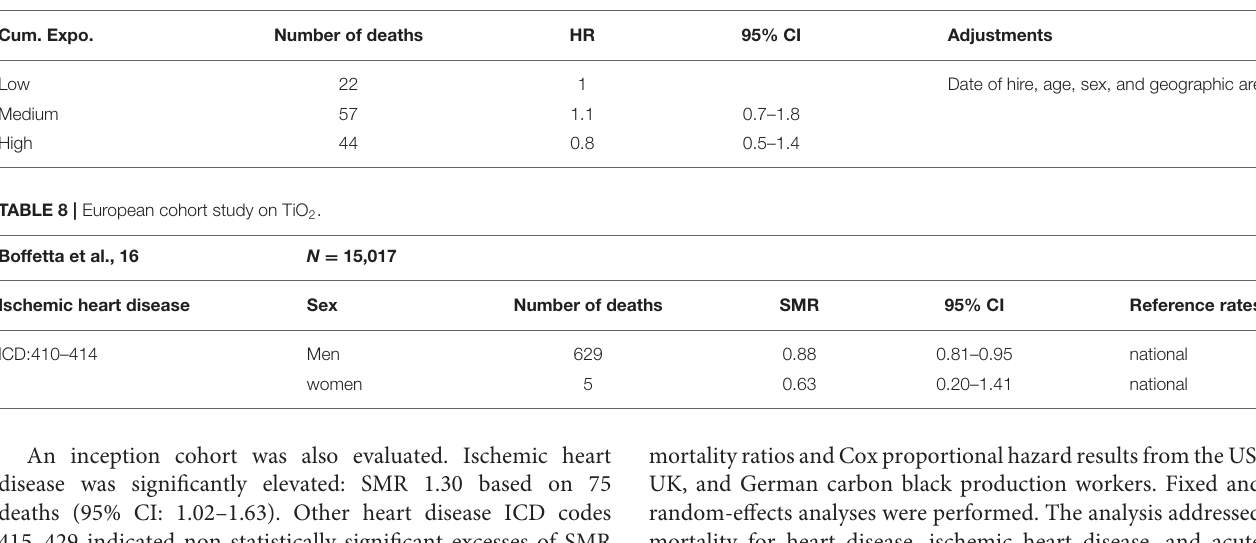
TABLE 7 | Internal comparisons for all heart disease (18). Fryzek et al., 14 Cum. Expo.